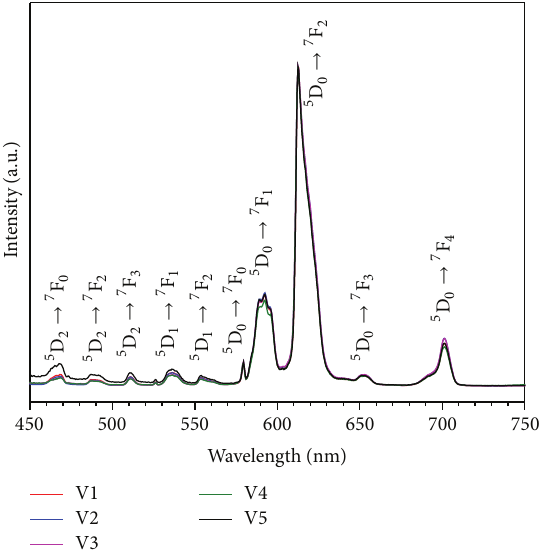
Figure 6: Emission spectra of ZnO-CdO-TeO 2 :Eu 3+ glasses moni- tored at 392 nm.